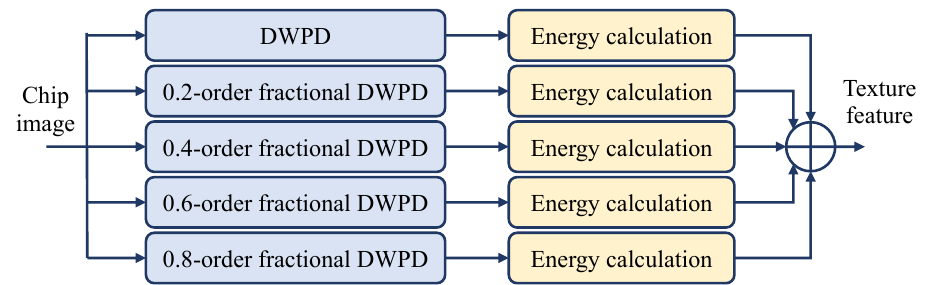
Figure 3. The structure of multi-order factional discrete wavelet packet decomposition